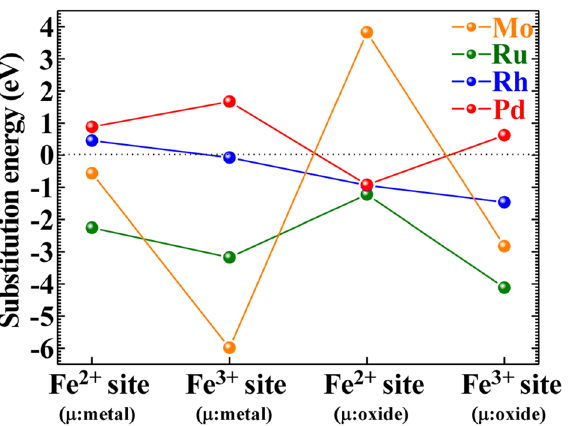
Figure 5. The substitution energy of PGMs/Mo ions with Fe 2+ /Fe 3+ ions in PB in the reduction and oxidation limits, respectively. The horizontal axis represents the substitution site and the type of the chemical potential μ in